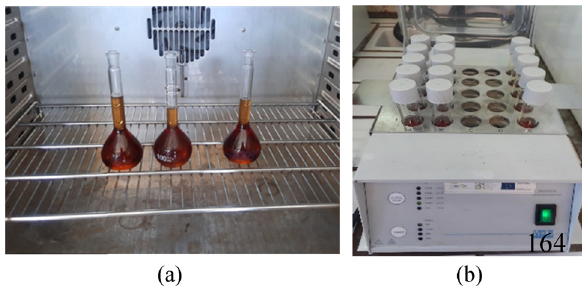
Figure 2: ( a ) Digestion of total humic extract in oven digestion; ( b ) digestion of the total humic extract in a CQO digester.